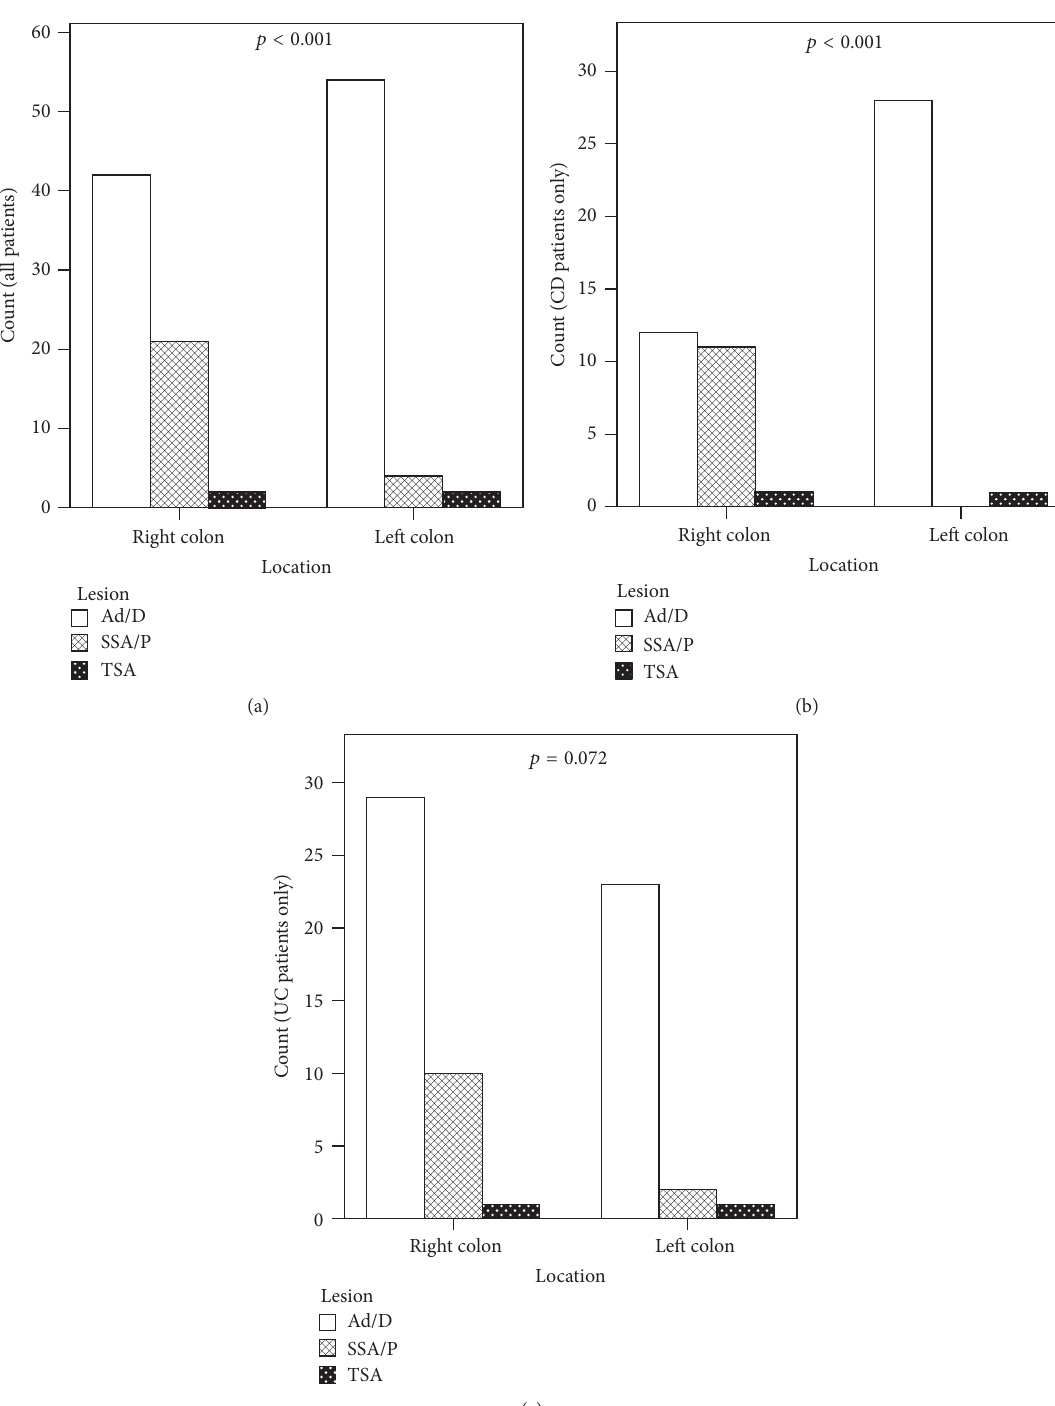
Figure 3: Anatomical distribution of conventional adenomas/dysplasia (Ad/Ds), sessile serrated adenoma or polyps (SSA/Ps), and traditional serrated adenomas (TSAs) grouped into right and left colon for (a) all patients studied, (b) patients with Crohn’s disease, and (c) patients with ulcerative colitis. The right colon is defined as proximal to the splenic flexure, and the left colon is defined as distal to and including the splenic flexure. 𝑝 values are for the comparison between Ad/Ds and